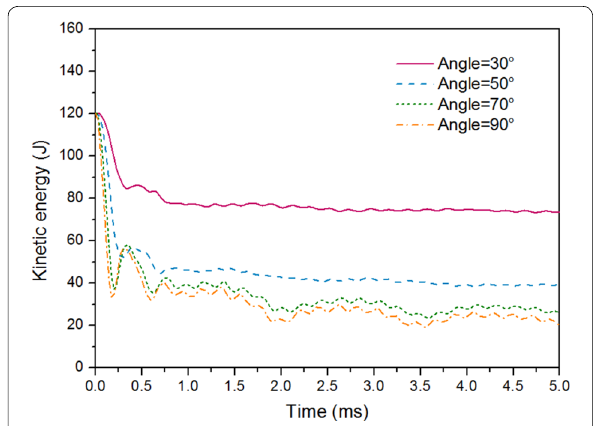
Figure 7 Kinetic energy versus time for different angles (impact velocity 135 =